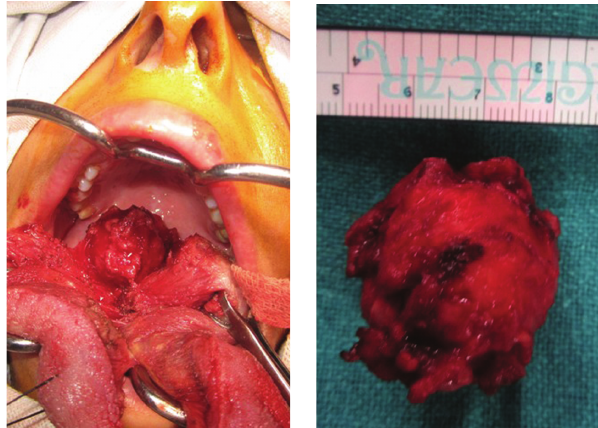
Figure 4: Appearance of tongue after 2 months following surgery and postoperative computed